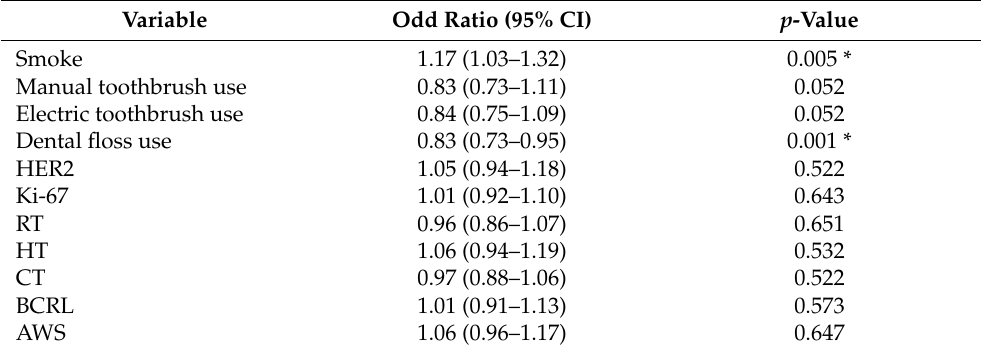
Table 4. Univariate Logistic regression between the Decayed, Missing, and Filled Permanent Teeth Index (DMFT), oral hygiene habits, and breast cancer